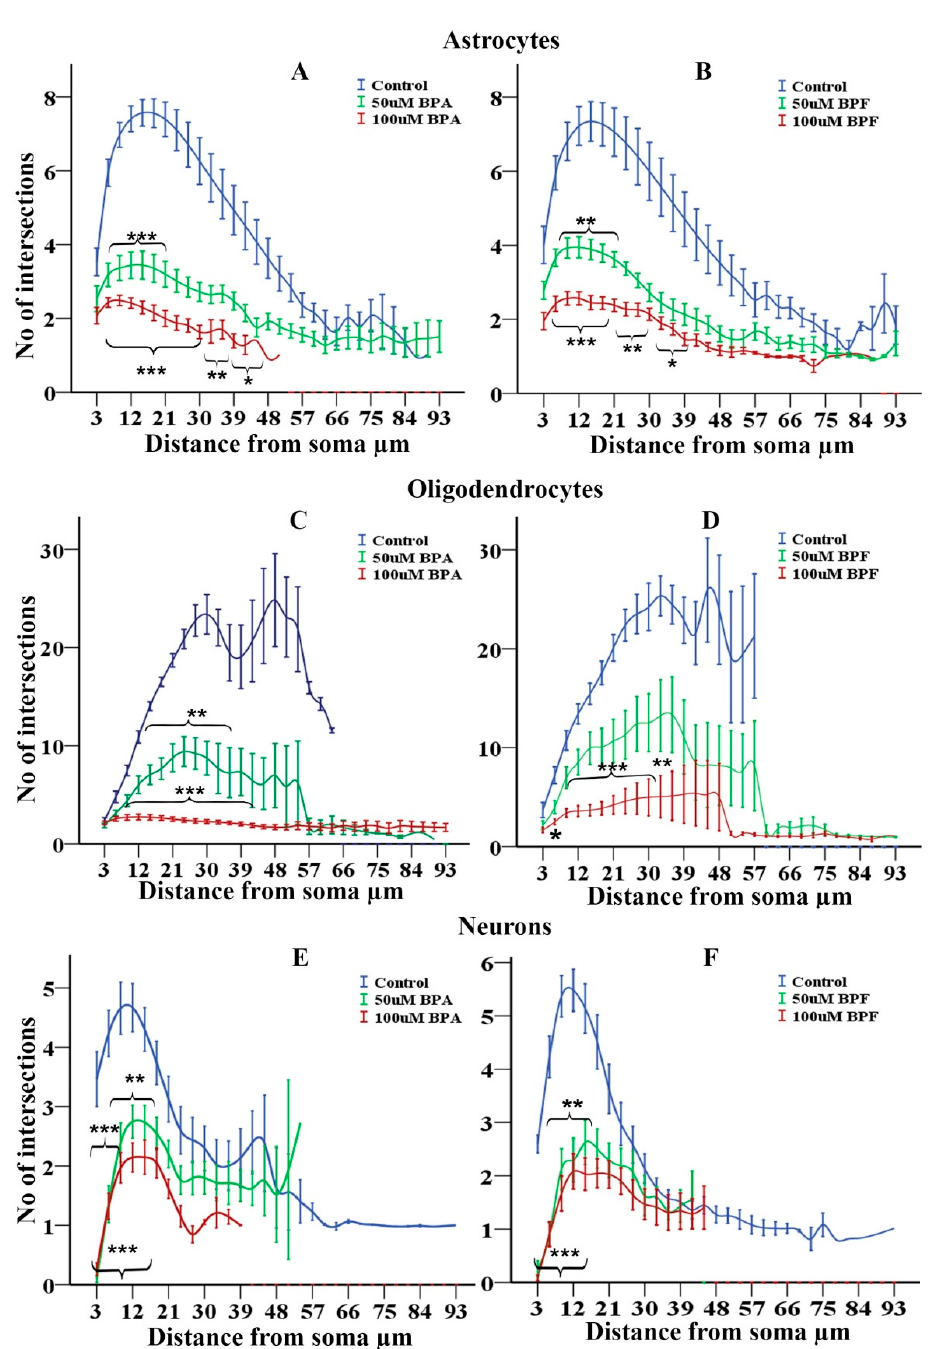
Figure 9. Effects of different doses of BPA or BPF treatment for seven days on morphometric analysis of astrocytes, oligodendrocytes, and neurons differentiated from rNSCs in relevant cell-specific directed differentiation medium. The number of intersections between the cellular processes and “Sholl circle” was used as an index of morphological changes of astrocytes differentiated from rNSCs ( A , B ), oligodendrocytes ( C , D ), and neurons ( E , F ). Differentiated astrocytes ( n = 216–222 per group), oligodendrocytes ( n = 178–180 per group), and neurons ( n = 271–261 per group) were stained with specific markers GFAP, mGalc, and MAP2, respectively, and nuclei stained with DAPI. Fluorescent signals were segmented and transformed into a binary mask for tracing complete cell morphology. Traced cell images were subjected to morphometric Sholl analysis to enumerate a number of intersection in each “Sholl circle”. Multiple comparisons of the number of intersections within 3 µm to 48 µm regions of astrocytes, oligodendrocytes, and neurons differentiated in the presence and absence of BPA or BPF are illustrated. Data shown are mean ± SE; * p < 0.05, ** p < 0.01, *** p < 0.001 compared with the relevant control